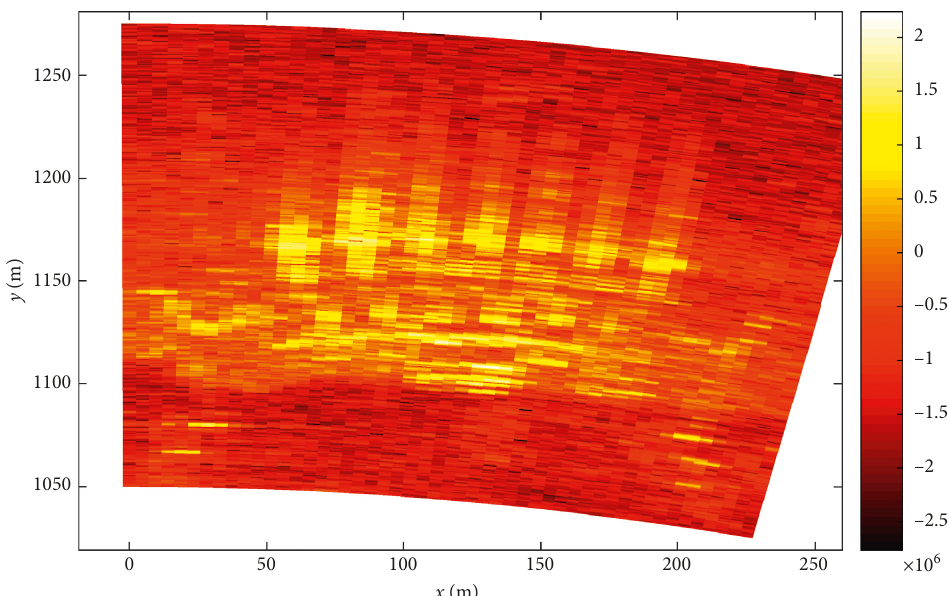
Figure 4: Interferometric image of the main body of the dam area (interferometric result of 1st and 2nd scene images, the x -axis represents the direction along the dam axis, and the y -axis represents the distance between IBIS-L and the dam).